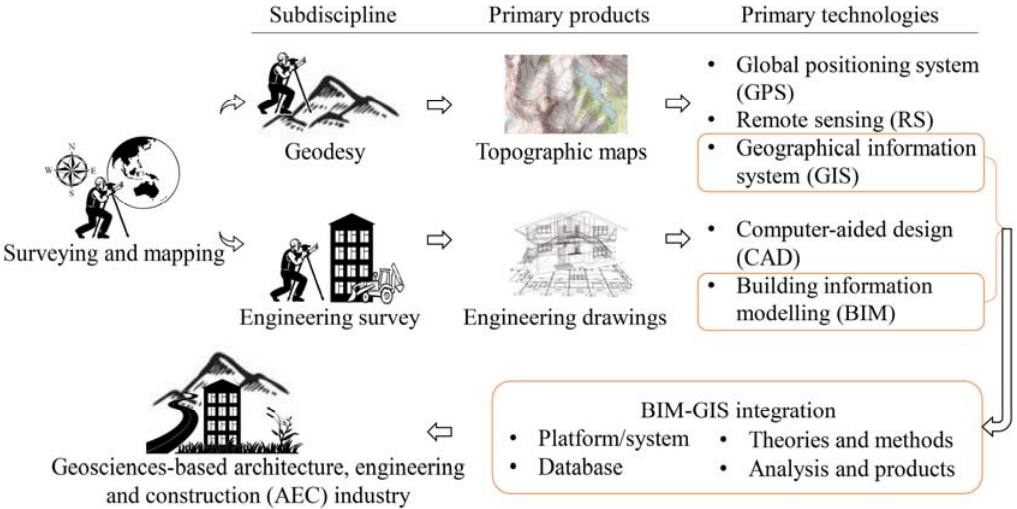
Figure 2. History of BIM-GIS integration from the perspective of surveying and